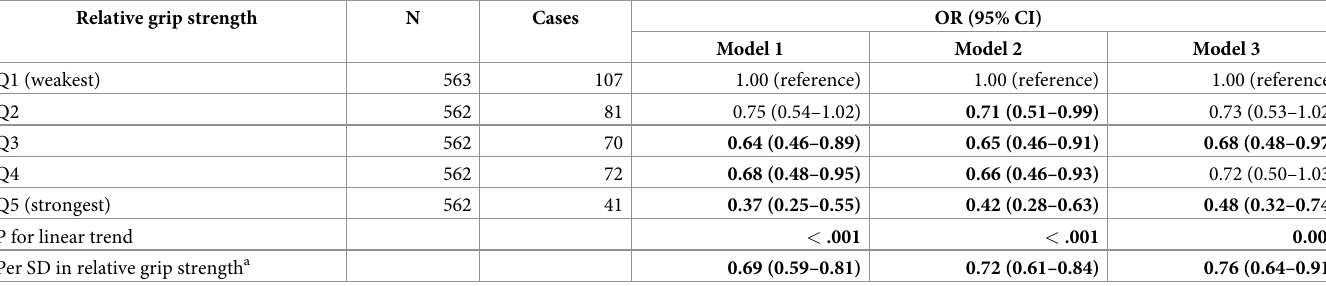
Table 2. Odds ratios of T2DM by quintiles of relative grip strength. Relative grip